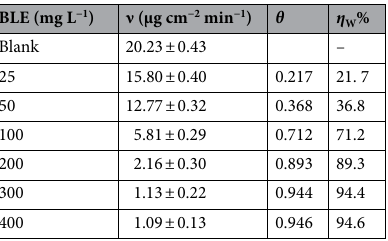
Table 1. Percentage corrosion inhibition efficiency of varied concentrations of BLE extract for X52-steel in 1.0 M HCl at 298 K calculated by weight loss method.